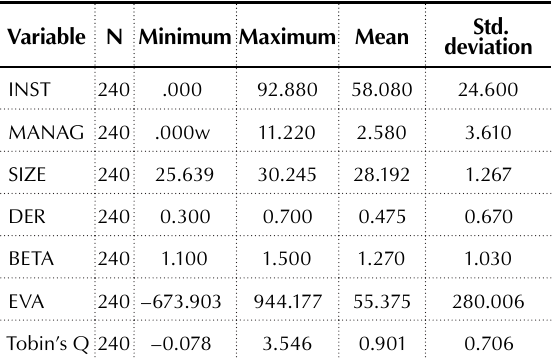
Variable N Minimum Maximum Mean